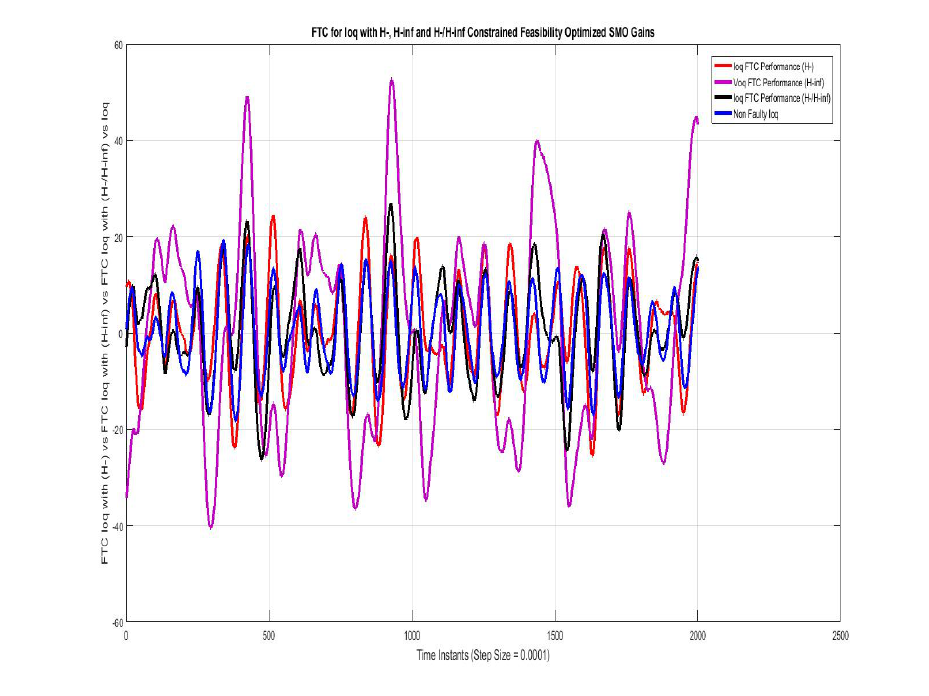
Figure 12. FTC for Ioq compared with feasibility optimized H − and H − / H ∞ SMO gains.